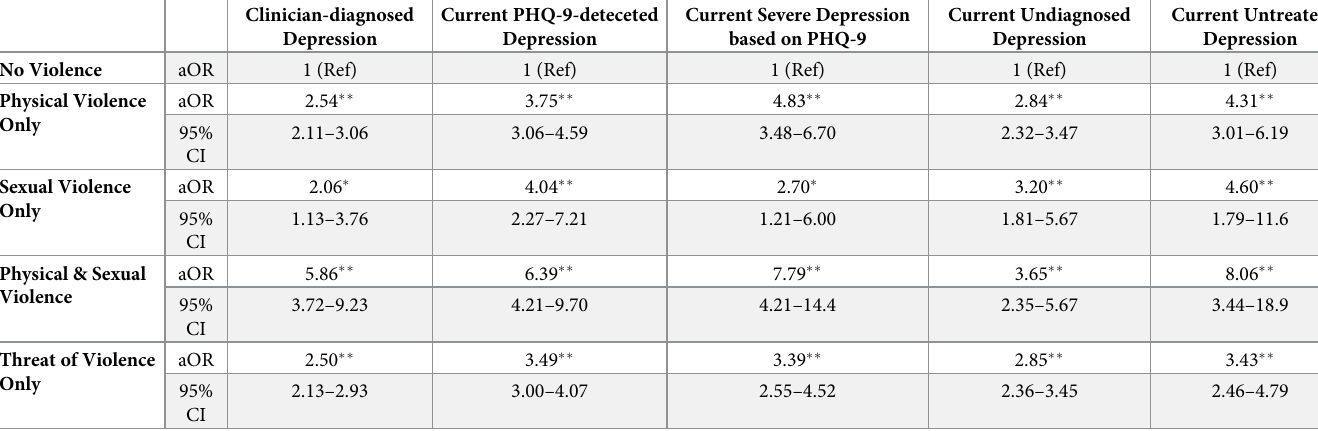
Table 4. Results from logistic regression models assessing associations between depression measures and types of violence